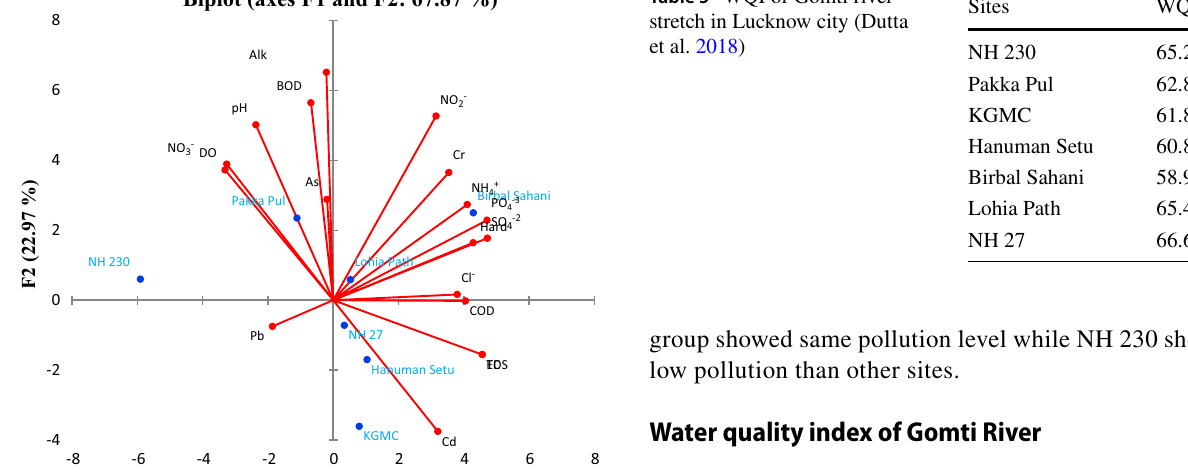
Table 5 WQI of Gomti river stretch in Lucknow city (Dutta et al.